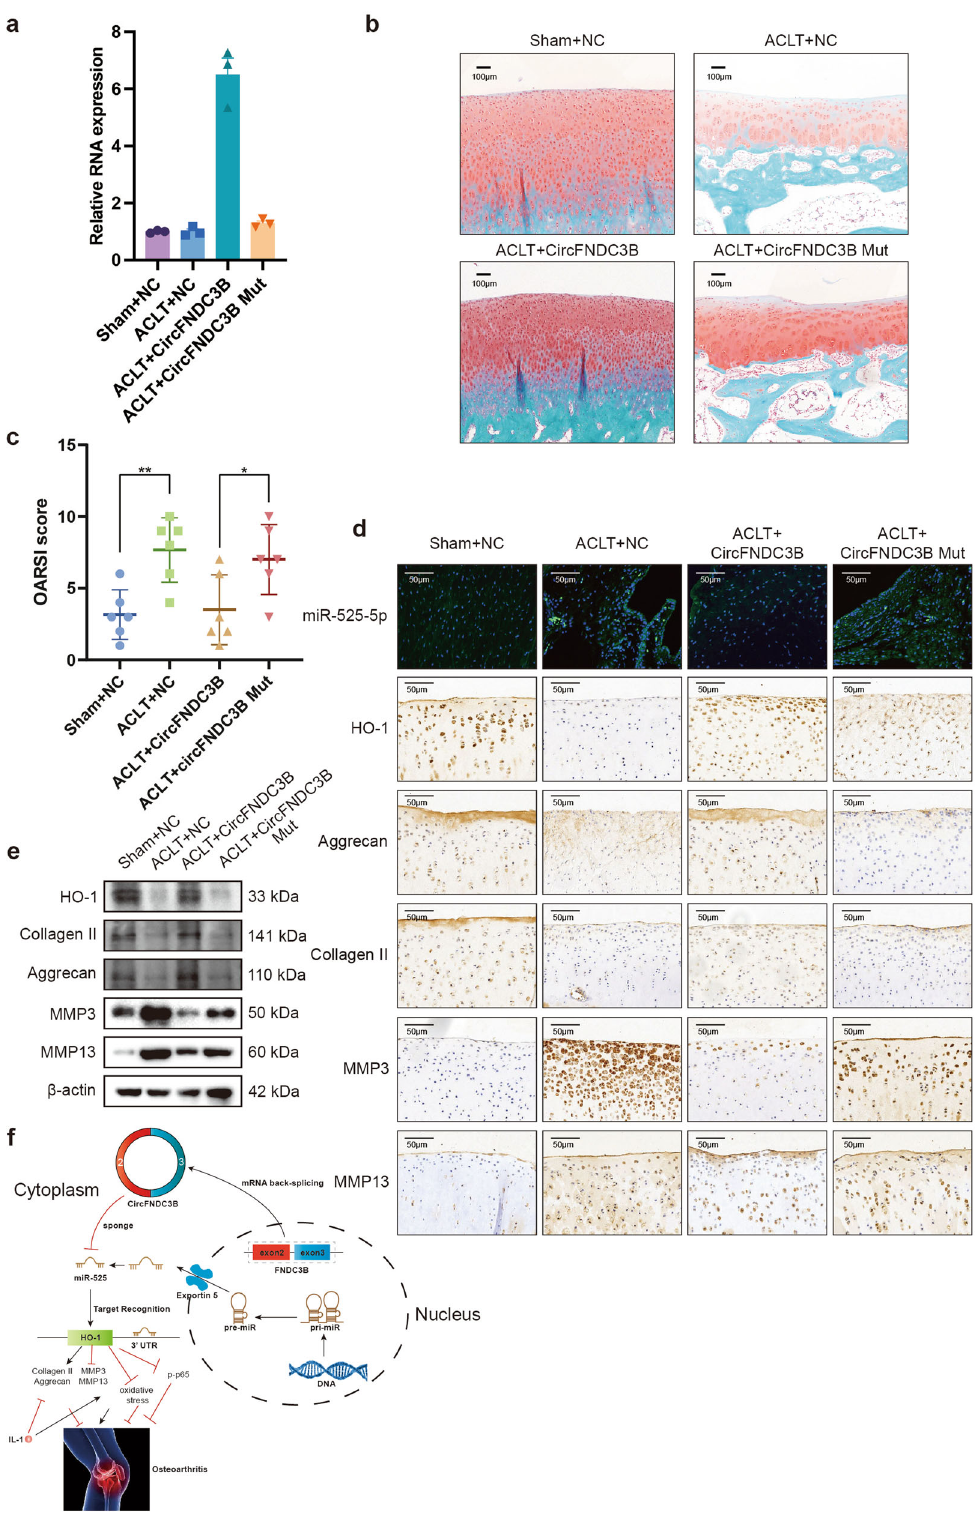
Fig. 9 Injection of CircFNDC3B alleviates OA in a rabbit ACLT model. a . RT-PCR analysis showed that the overexpression of CircFNDC3B in rabbit cartilage. ( n = 6). b . Safranin-O/fast green staining of cartilage from 4 groups of rabbits. Scale bar, 100 µ m. c . OARSI score used for the assessment of histological changes of rabbit knee cartilage. ( n = 6). d . Histological analysis of rabbit knee cartilage by FISH and immunohistochemistry. MiR-525-5p, HO- 1, MMP3, MMP13, Collagen II, and Aggrecan expression were examined. Scale bars, 50 μ m, 100 μ m. e . Western blot analysis of HO-1, MMP3, MMP13, Collagen II, and Aggrecan in each group. f . Schematic illustration of the circFNDC3B/miR-525-5p/HO-1 axis. Mean ± SEM; *p < 0.05; **p < 0.01; ***p < 0.001 by Student ’ s t